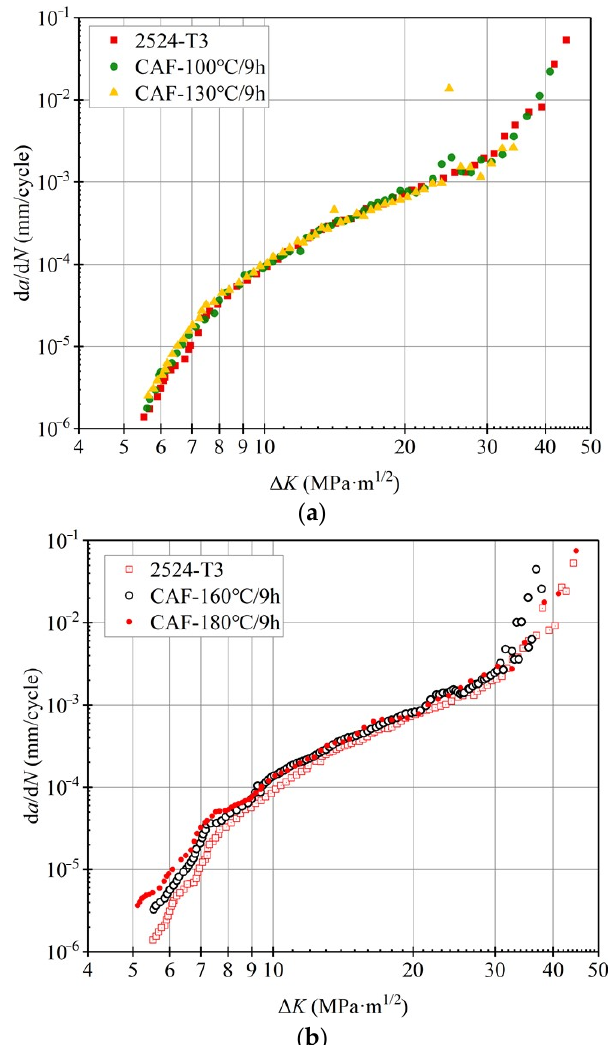
Figure 3. Fatigue-crack propagation rate da/dN- Δ K curves of 2524 aluminum alloy at different creep-aging temperatures: ( a ) 100 °C and 130 °C; ( b ) 160 °C and 180 °C.